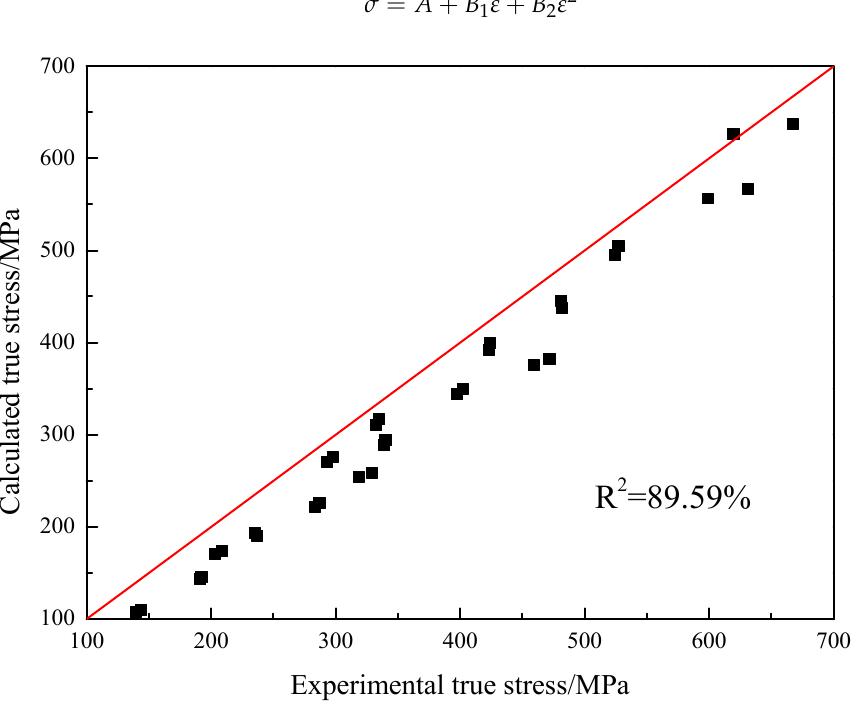
Table 2. Parameters for HS model for the GH3230 superalloy double-sheet.